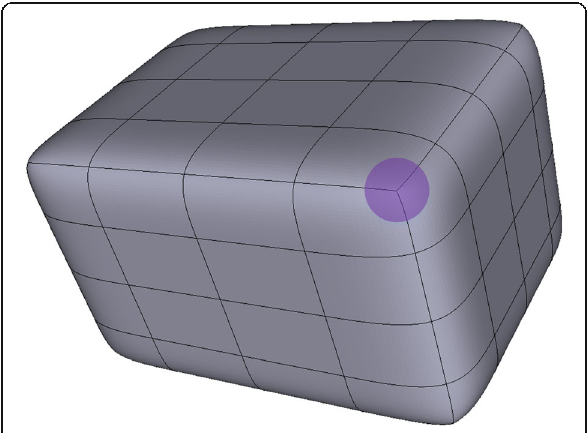
Fig. 4 A cube T-spline model. An extraordinary point is marked in the purple region